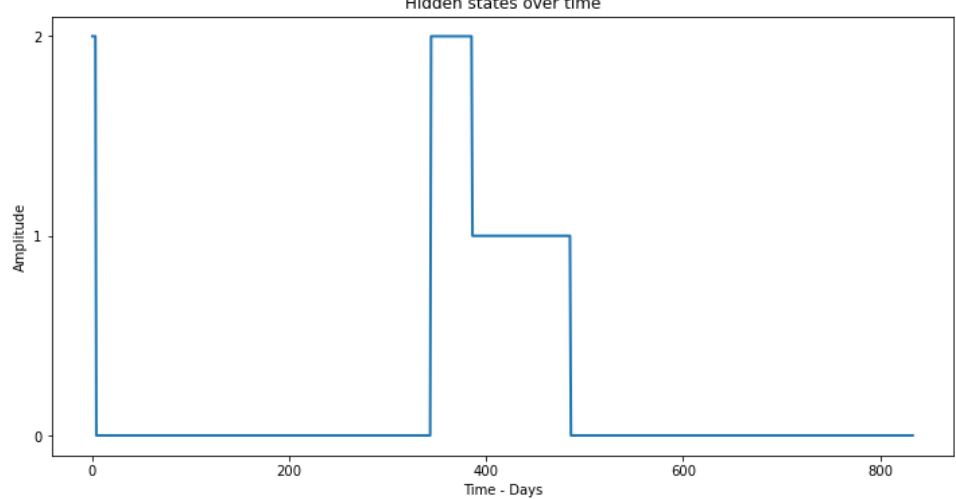
Figure 9. Hidden States (health states of the production equipment) over the study